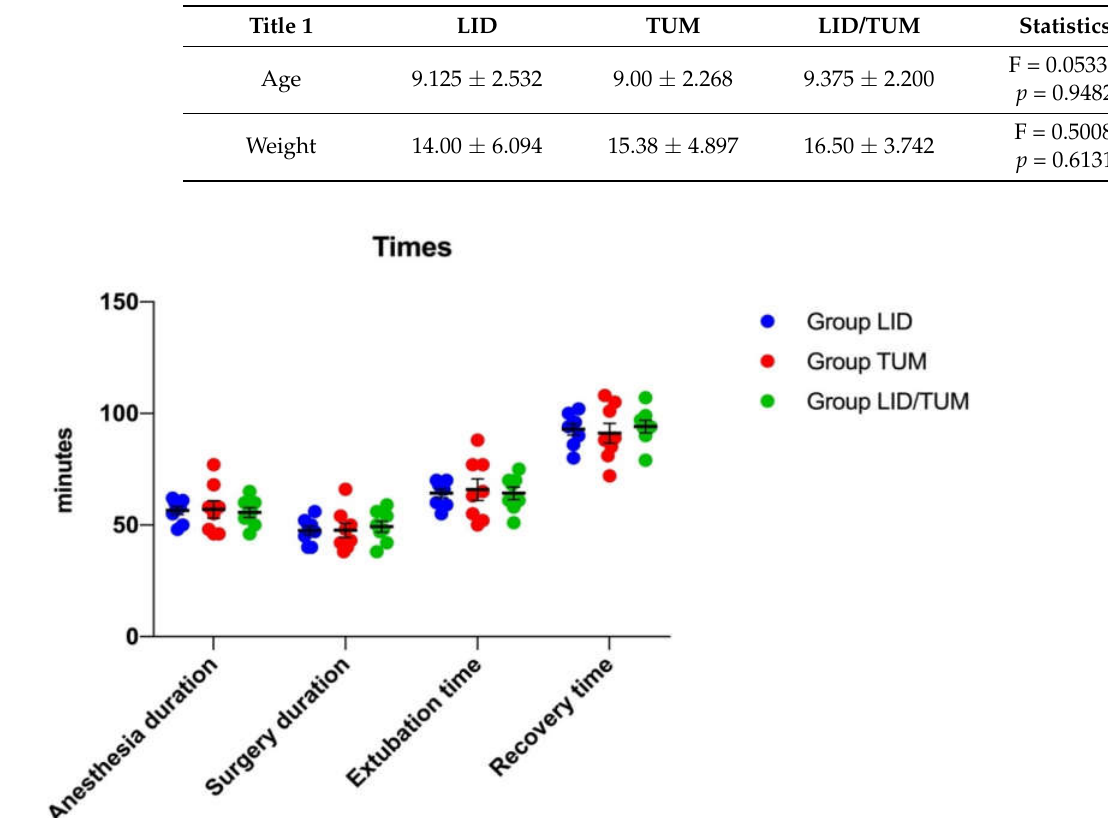
Figure 1. A scatter dot plot showing the anesthesia duration, the surgery duration, the time to endotracheal extubation, and the recovery time in the three groups. Blue, red and green dots indicate the single measurements scattered in groups; bars indicate means and standard errors; LID: Lidocaine group; TUM: Tumescent anesthesia group; LID/TUM: Lidocaine/Tumescent anesthesia group.